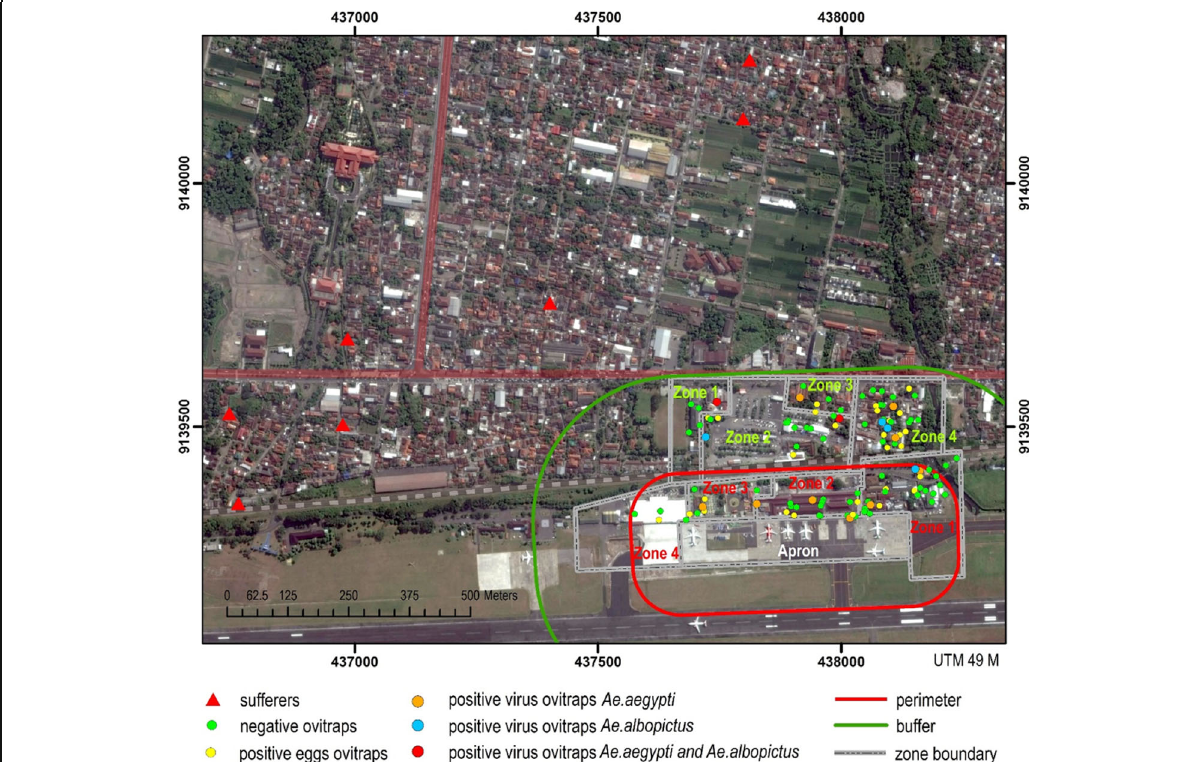
Fig. 1 Distribution map of dengue virus and dengue cases in Adisucipto Airport Yogyakarta in every Zones. Four zones in perimeter area are cargo log (zone 1), terminal A (zone 2), office (zone 3), and terminal B (zone 4), while four areas in buffer area ( — ) are terminal B (zone 1), parking and public facilities (zone 2), neighborhood 7 (zone 3), and neighborhood 8 (zone 4). Buffer area has more potential as breeding sites of Aedes spp. mosquitoes. The distribution of Aedes spp. mosquitoes based on positive Ovitrap Index in Yogyakarta ’ s Adisucipto Airport was found evenly distributed in the area, positive eggs ovitraps, positive virus ovitraps Ae . aegypti , positive virus ovitraps Ae . albopictus , and positive virus ovitraps Ae . aegypti and Ae . albopictus , with the highest number of positive OI found in the zone 4, the neighborhood 8 (RT 8) of village of Maguwoharjo. Negative ovitraps and dengue patients (sufferers) distribution may also be observed